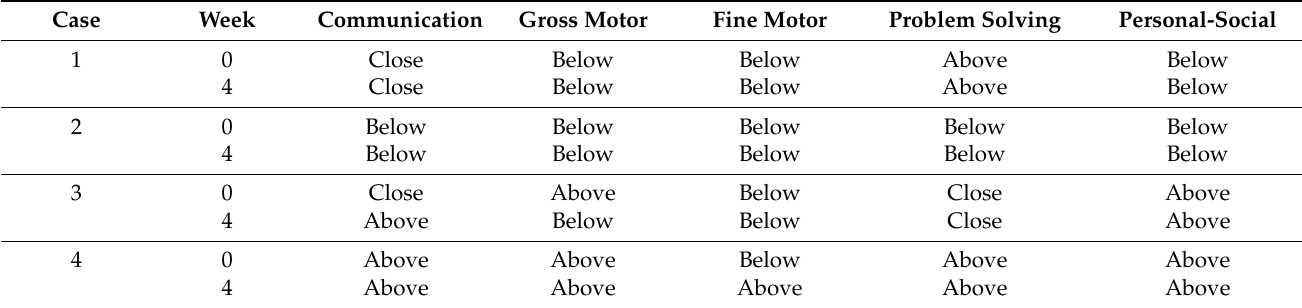
Table 3. Ages and Stages Questionnaire (ASQ) State Relative to Cut Off.